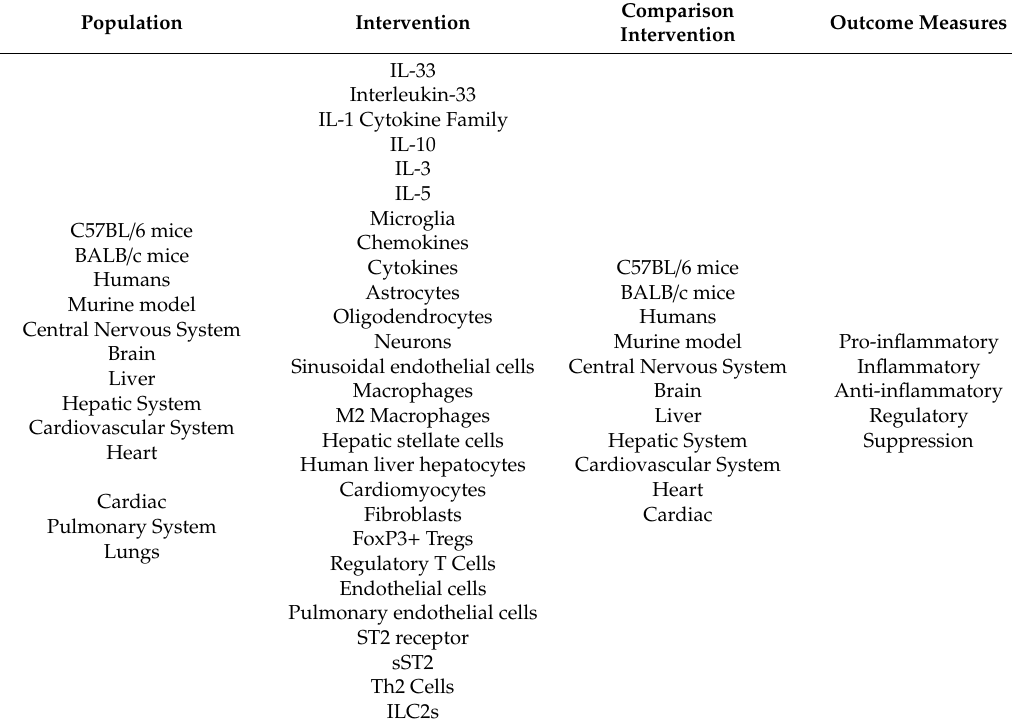
Table 1. Detailed keywords used in search